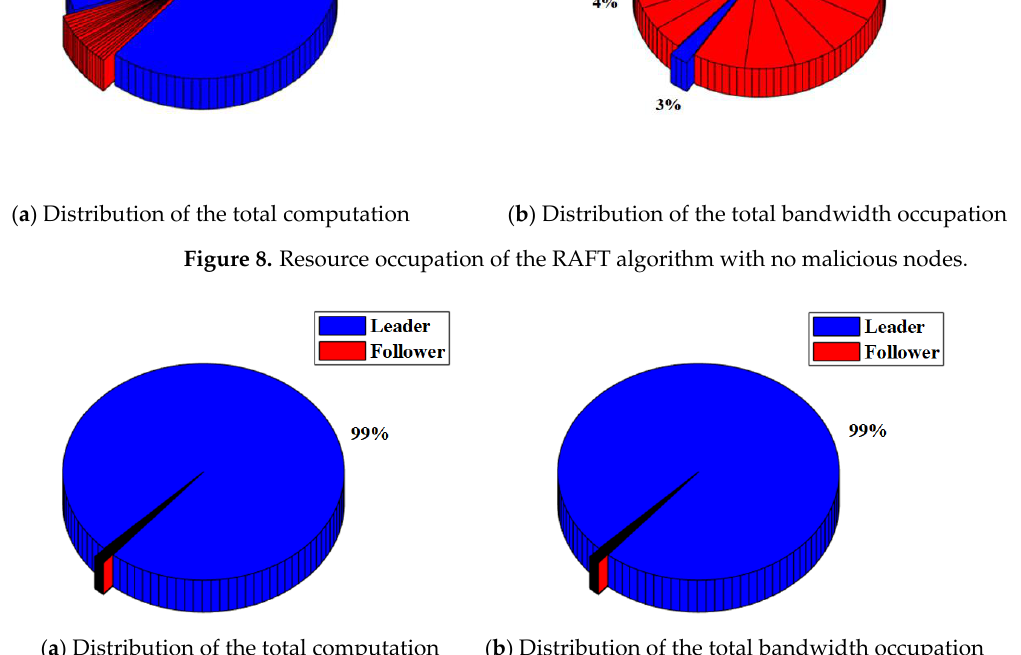
Table 4. The performance of the PBFT Figure 9. Resource occupation of the RAFT algorithm with malicious nodes.